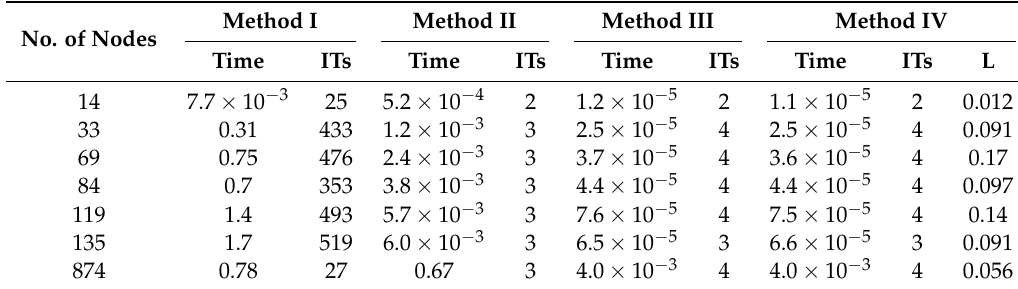
Table 3. Radial Network Test.